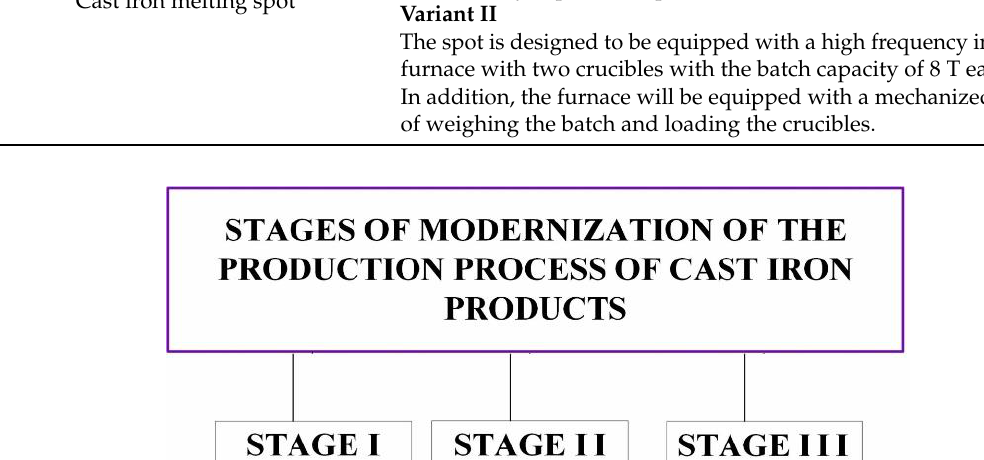
Figure 7. The first stage of modernization of the casting process.